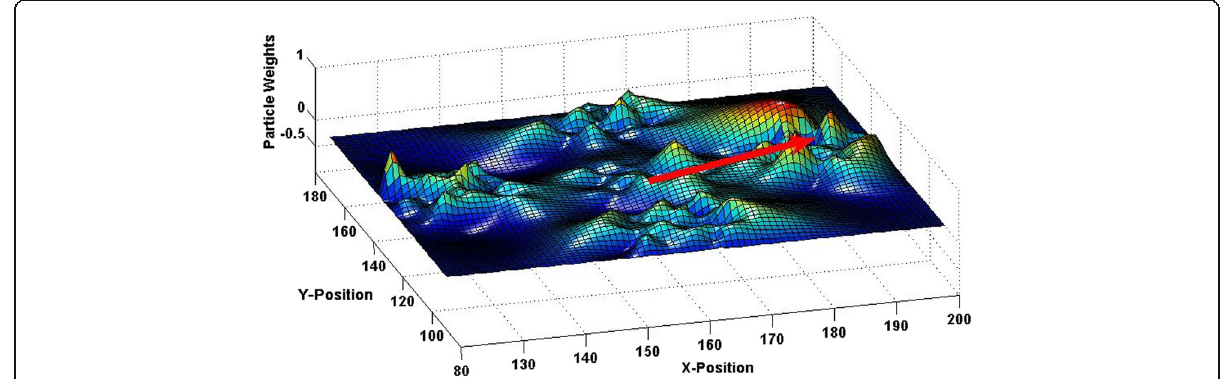
Fig. 7 Sub-particle drift